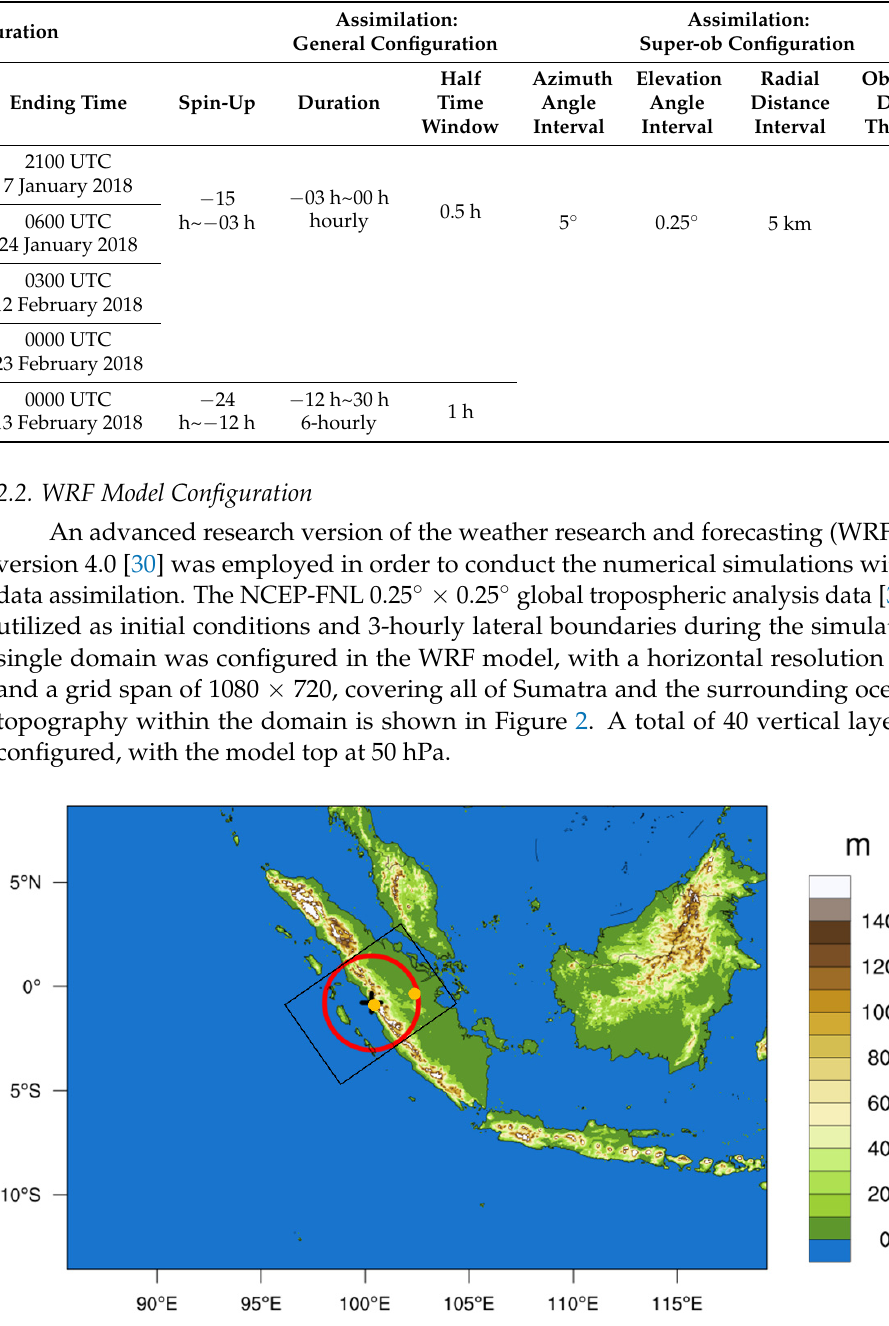
Figure 2. Terrain height (m) in the WRF domain. The black cross and red circle mark the Padang radar location and data coverage. The orange dots mark the ISD sites Tabing (0.9°S, 100.4°E) and Japura Airport (0.4°S, 102.3°E). The solid black box marks the transect used for the Hovmöller dia-